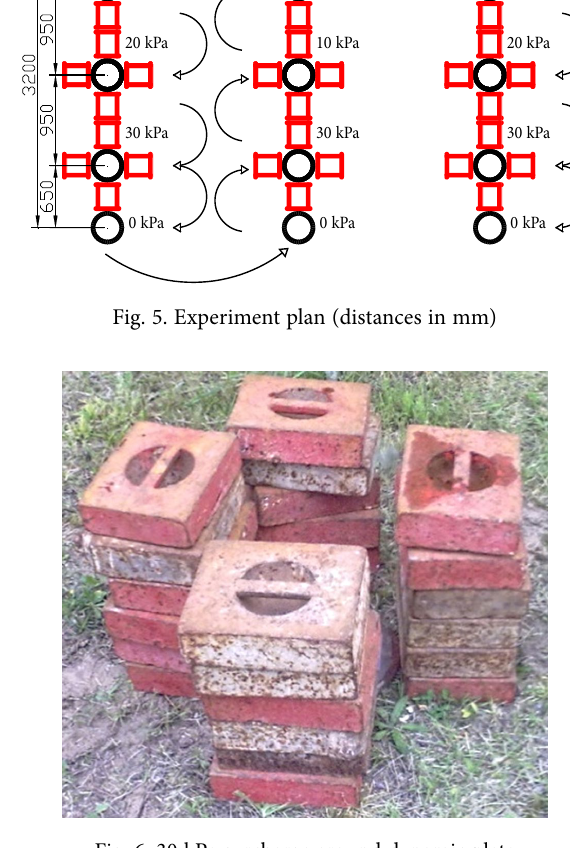
Fig. 6. 30 kPa surcharge around dynamic plate